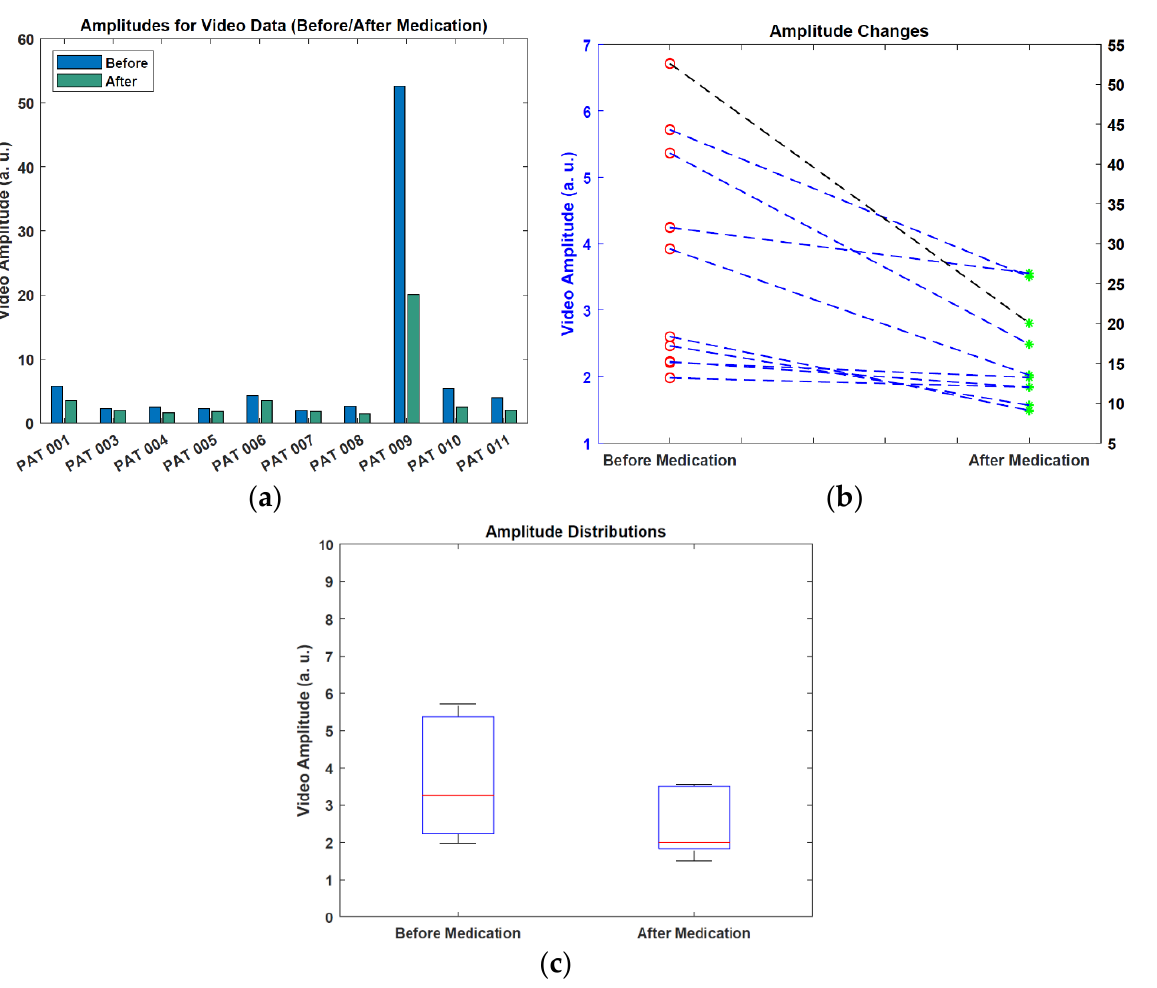
Figure 10. Visualization of the amplitude results. ( a ) Amplitude estimations. ( b ) Amplitude changes (note the different scale for one data point). ( c ) Amplitude distributions (values > 10 a.u. are not shown).